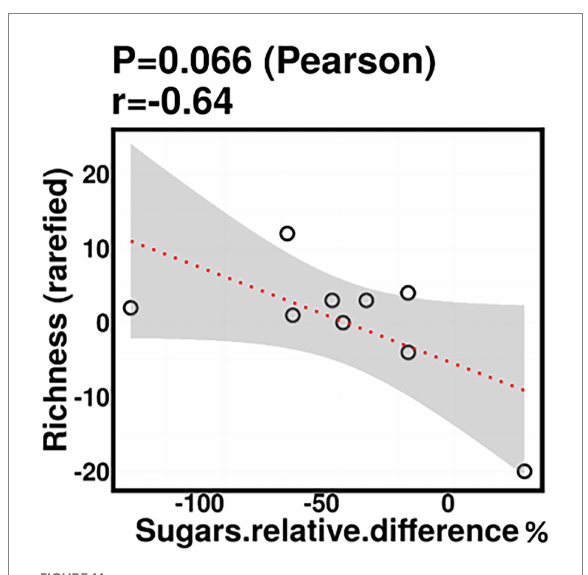
FIGURE 11 Infant stool bacterial richness was negatively correlated with change in maternal sugar intake with the dietary intervention; however, this was not statistically